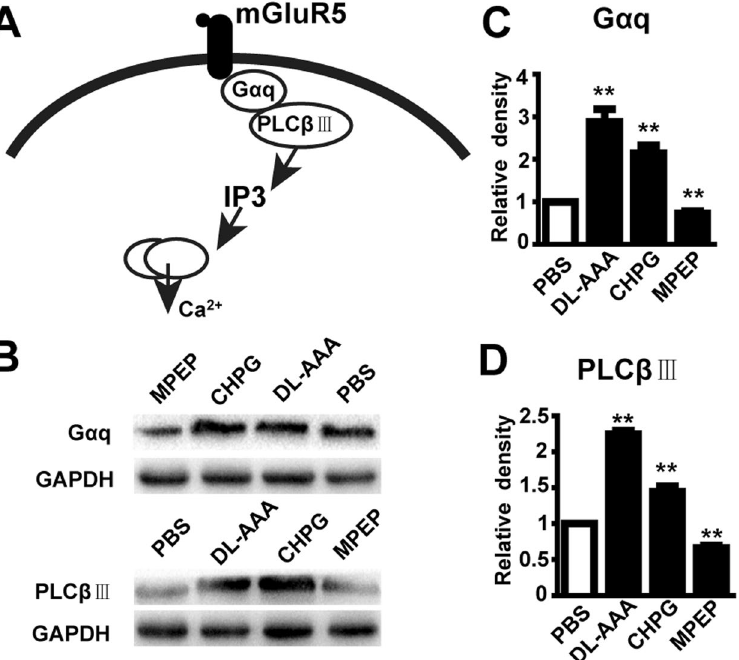
Figure 5. mGluR5 activated the G α q signaling pathway in Müller cells. ( A ) Schematic illustrating the mGluR5 G α q secondary-messenger pathway, following glutamate binding to the receptor. ( B ) Top : Representative western blotting showing the expression of G α q following injection with DL-AAA, MPEP or CHPG, vs. PBS control. GADPH as loading control. Bottom : The same for expression of PLC βΙΙΙ . ( C ) Quantified G α q expression level following injection with DL-AAA, CHPG or MPEP, vs. PBS control (n = 3 for each bar). ( D ) The same as C but for PLC βΙΙΙ expression (n = 3 for each bar). IP3, inositol trisphosphate. ** p <